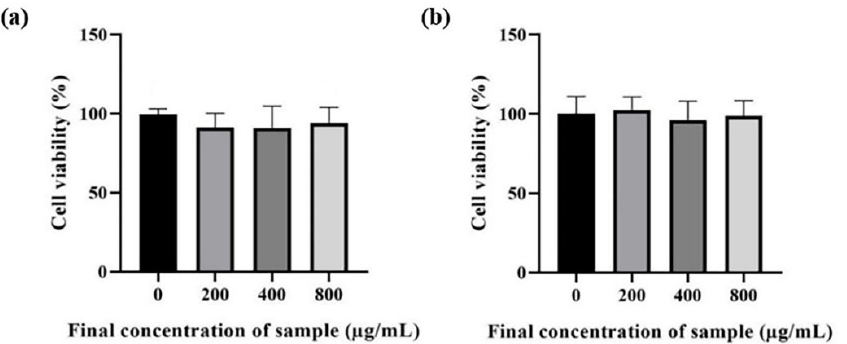
Figure 5. The cytotoxic effects of mulberry root extract on tissue culture cells. ( a ) HaCaT ( b ) Vero. The results are the means of two independent experiments, and each data point was obtained in triplicate. Error bars represent the standard error of the mean.